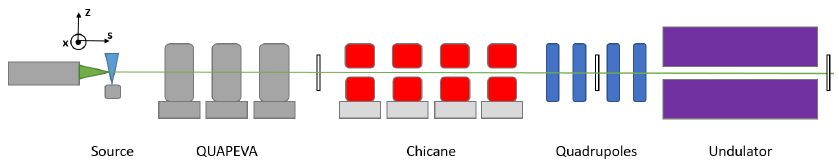
Figure 1. COXINEL transport line scheme. Left to right: Laser pulse focused on a gas jet ( blue ), triplet of QUAPEVAs ( grey ), first screen for electron beam profile measurement ( white ), chicane ( red ), a second set of electro-magnetic quadrupoles ( blue ), screen before and after the undulator ( white ), and cryo-ready undulator ( purple